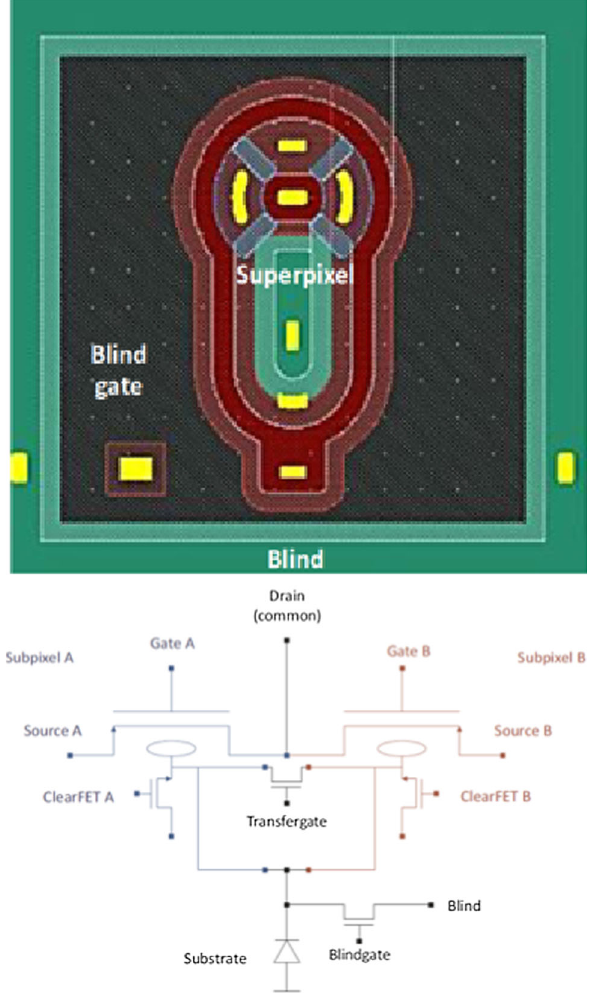
Fig. 8 Layout (top) and equivalent circuit representation (bottom) of RNDR superpixel with electronic shutter. The pixel size here is 75 × 75 µ m 2